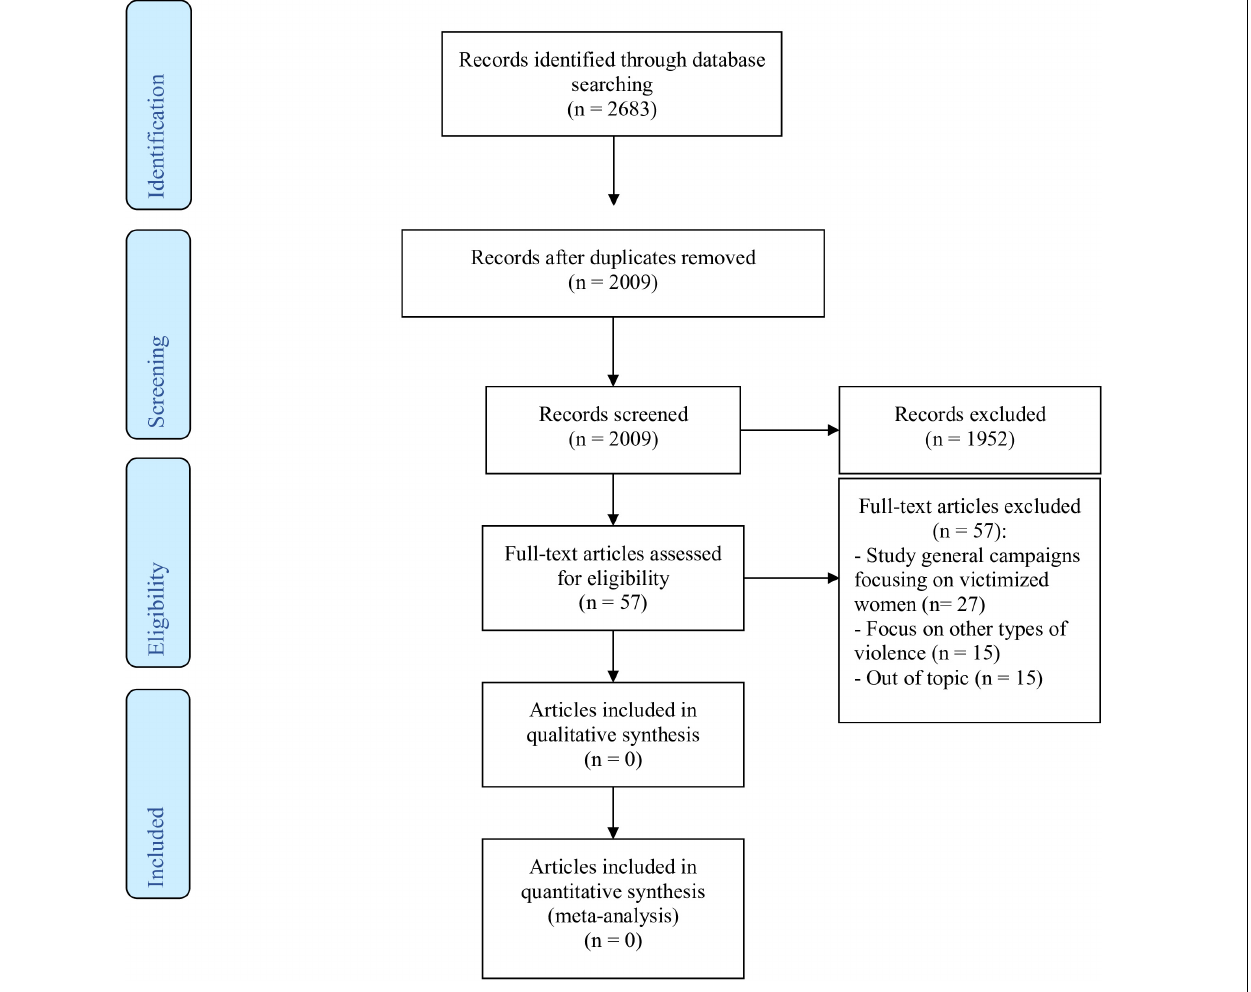
FIGURE 1 | Flowchart of article search and screening